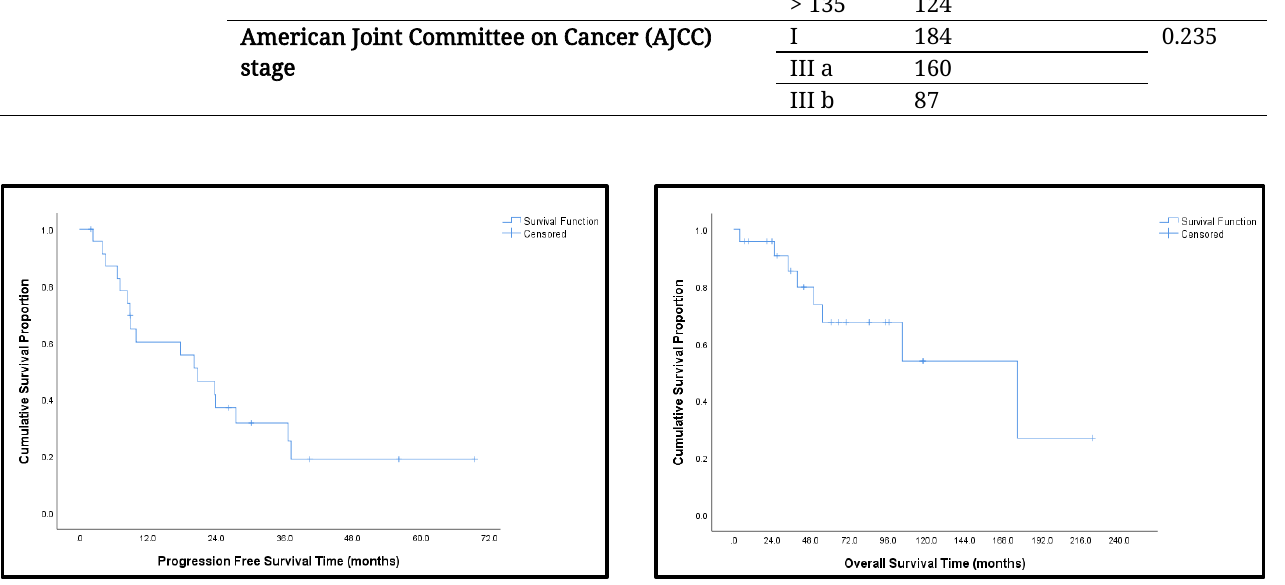
Figure 2: Kaplan-Meier curve of overall